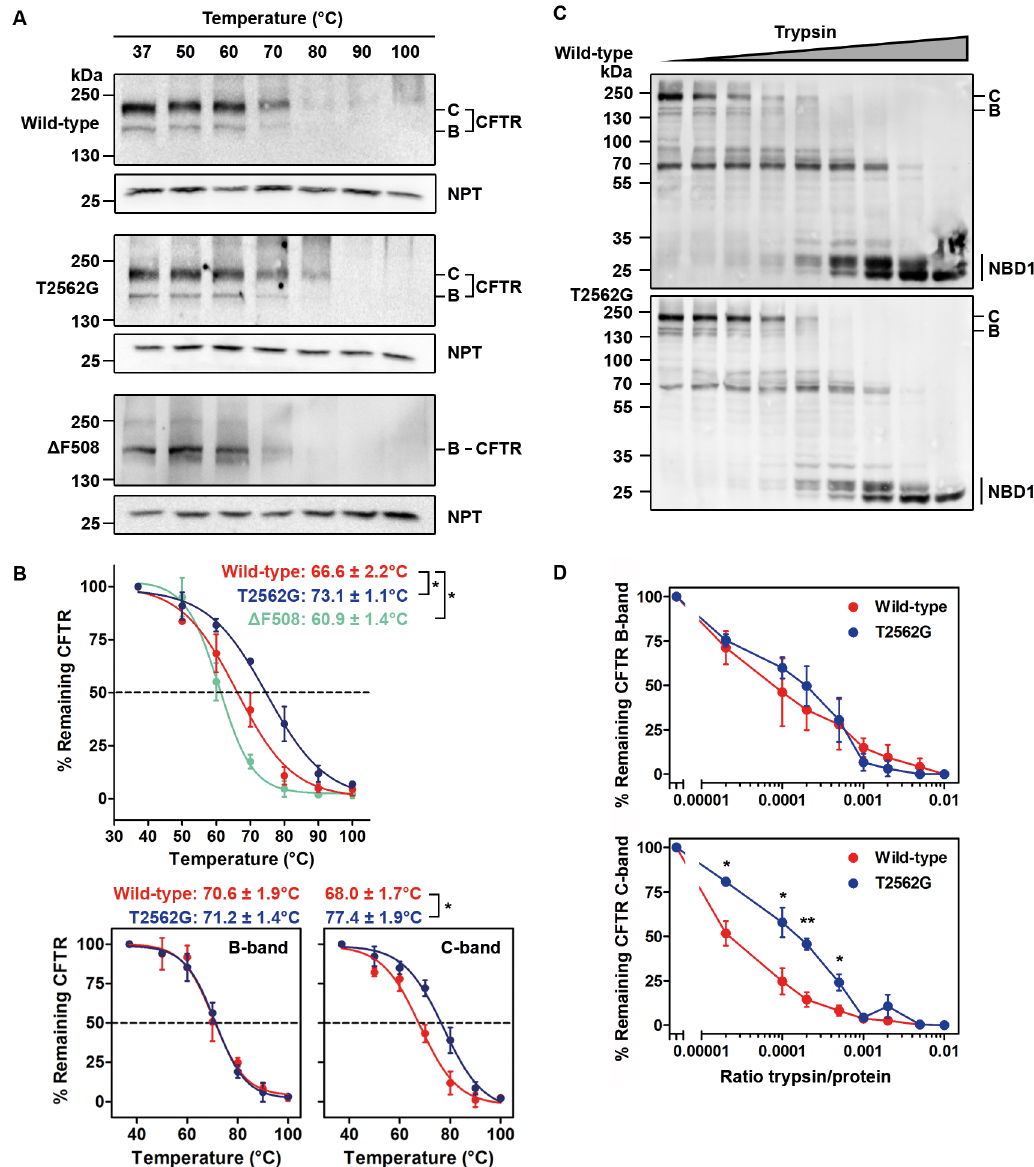
Fig 2. The T2562Gsynonymous single nucleotide polymorphism (sSNP)altersCFTR stability. ( A )Representative immunoblots or westernblots (WB) showingtemperature-inducedaggregation of CFTR variants. B and C denote immatureand mature CFTR protein,respectively. ( B )Quantification of the thermal aggregation propensityfor the CFTR variantsfrom panelA. The total amountof CFTR protein(sum of bandsB and C, upperpanel)or bandB and bandC separately, respectively, (bottom panel)at the indicatedtemperaturesrelativeto those at 37˚C is shown.Thermal aggregation temperatures ( T a ) are means ± SEM ( n = 4–7); * P < 0.05. ( C )Representative WBs ( n = 4) of limitedtrypsin digestionof wild-typeand T2562G-CFTR in semi-intact HeLacells probedwith anti-CFTR nucleotide-binding domain1 (NBD1) (660) antibody.NBD1indicatesNBD1-containingfragments;numberson the left are molecularmass standards. ( D )Quantification of bandsB and C of CFTR from panelC relativeto untreated samples(set to 100%).Data are means ± SEM ( n = 3); * P < 0.05, ** P < 0.01. The underlyingdata of panelsB and D can be foundin S1 Data.